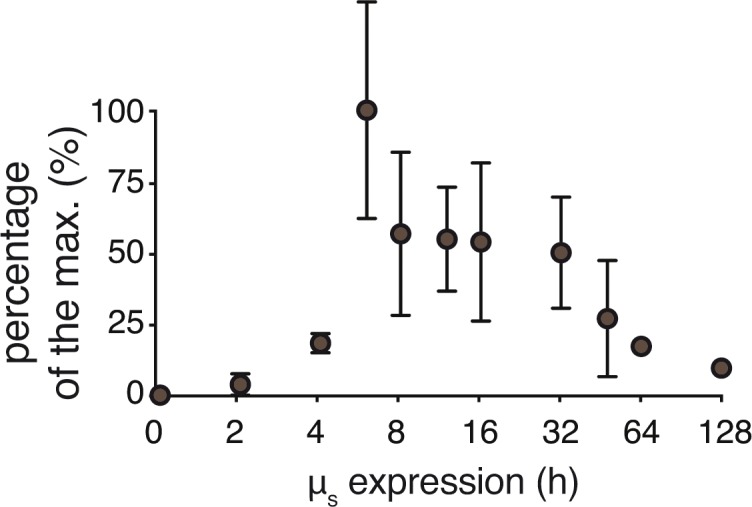
Transitioning from acute, full-geared to chronic, submaximal ATF6α signaling upon µs expression.Levels of ATF6α-p50 in Figure 4C and replicate experiments were quantified, normalized to α-tubulin levels, and expressed in percentages of the maximal ATF6α-p50 level that was reached. Mean and s.e.m. are shown (n = 1–3 depending on the time point assessed).